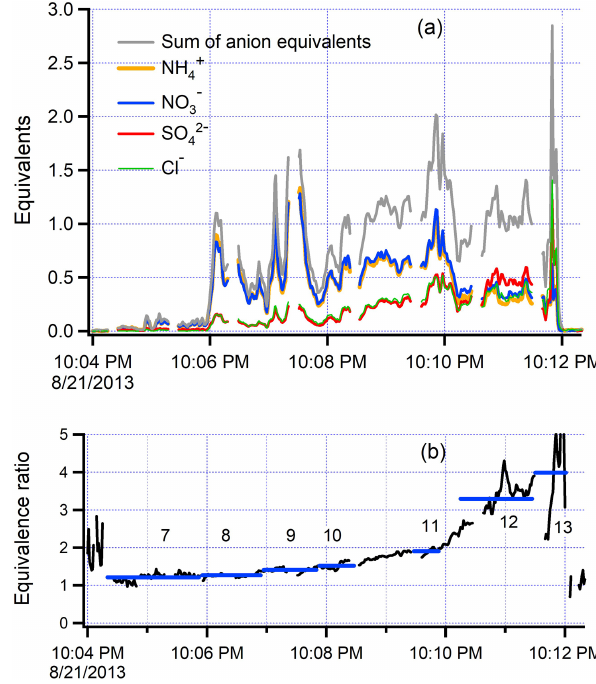
Figure 9. (a) Time series for inorganic species from the along- plume segment of flight 821b. Similar format to Fig. 8. Equivalents are equal to species molecular weight divided by charge. Sum of an- ion equivalents consists of NO − , SO 2 , and Cl. (b) Equivalence ra- 3 4 + Cl)/NH + tio = (NO 3 − + SO 2 . In the frame of the moving plume, 4 4 the newly emitted smoke (transect 13) has an equivalence ratio of 4. The equivalence ratio steadily decreases, nearly reaching a value of 1.0 at the end of the along-plume flight segment (transect 7). Values outside of the plume are at much lower concentration and suscepti- ble to error from background